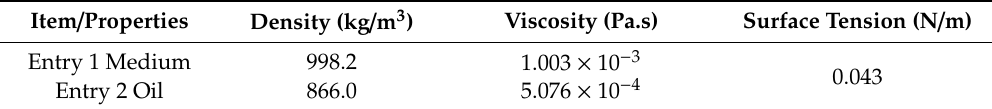
Table 1. Physical properties of the medium and